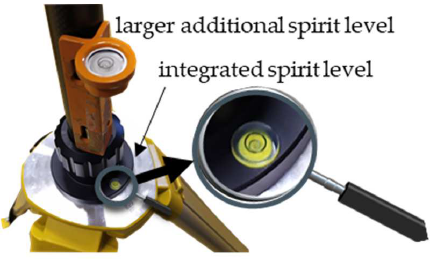
Figure 13. Larger additional spirit level added to the D-RTK2 tripod.